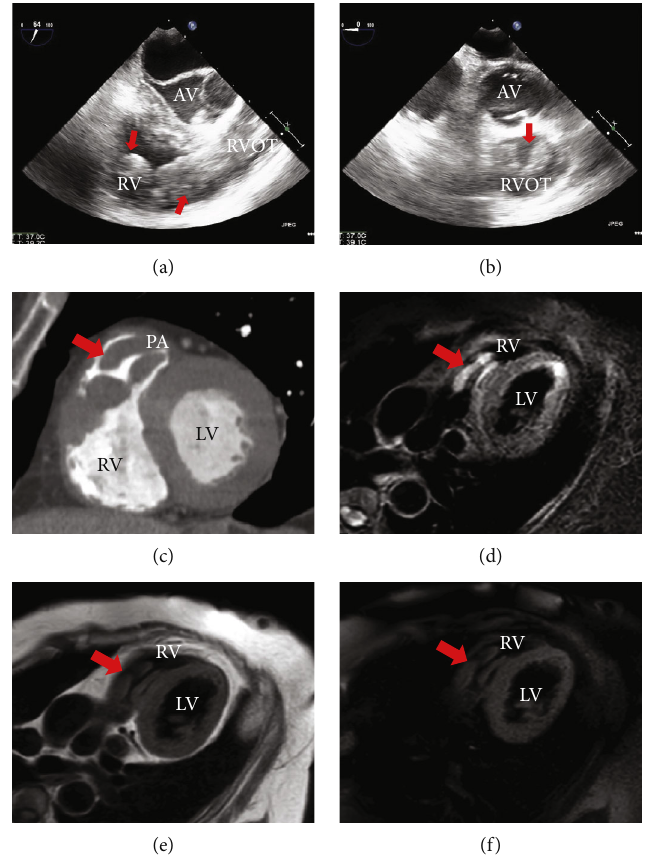
Figure 2: Transesophageal echocardiography, cardiac CT, and MRI appearance. Transesophageal echocardiography showed elongated mass-like structure (arrow) in the right ventricle (a, b). Short axis view of cardiac computed tomography scan revealed a well-de fi ned mass lacking contrast enhancement in the right ventricle below the pulmonary artery valve (c), and cardiac magnetic resonance imaging showed some masses which had hypersignal intensity on fat-saturated T2-weighted image (d), isointensity on T1-weighted image (e), and no suppressed signal on fat-saturated T1-weighted image (f). (AV: atrioventricular; RV: right ventricle; RVOT: right ventricular out fl ow tract; LV: left ventricle; RV: right ventricle).